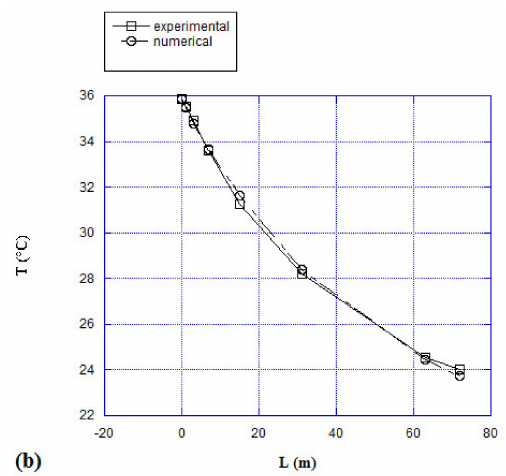
Figure 4. Experimental and numerical results for temperature of the air flowing at 5 m s − 1 and inlet temperature of ( a ) 34.9 ◦ C and ( b ) 35.9 ◦